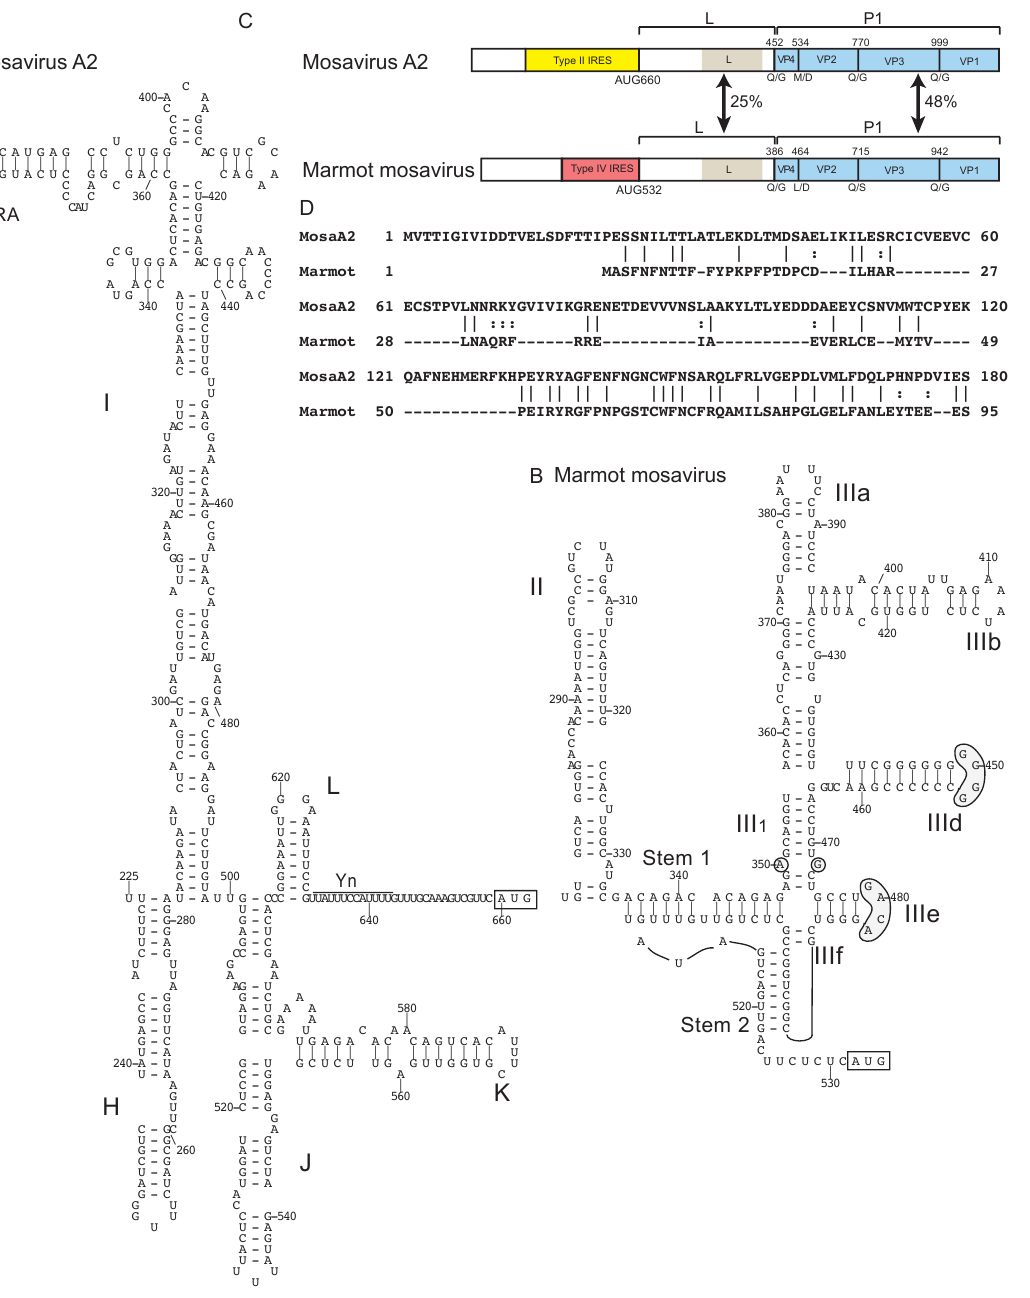
Figure2. Two di ff erentclasses ofIRES inthe genus Mosavirus of Picornaviridae . ( A )Model ofthe structure of the type II IRES of mosavirus A2 strain SZAL6-MoV / 2011 / HUN (NCBI ref. seq. NC_023987.1)